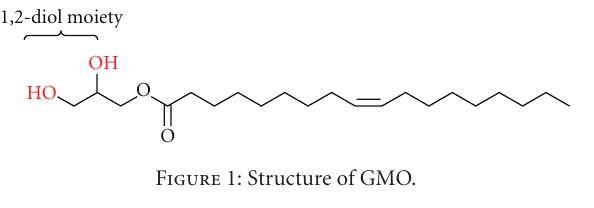
Figure 1: Structure of GMO.